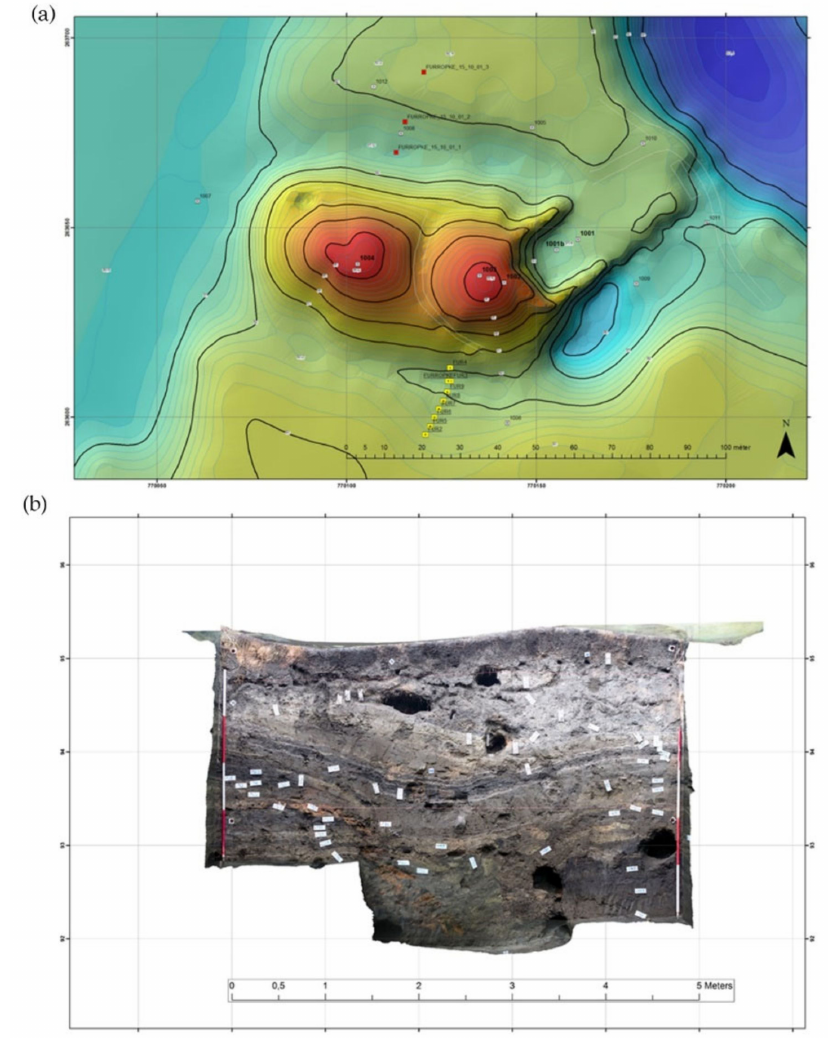
Figure 3. ( a ) Geodetic survey map of Borsodiv á nka-Marhaj á r á s-Nagyhalom. Both tops belong to the tell, and it was only disturbed and divided into two in early modern times. ( b ) Profile with the layer sequence of the tell